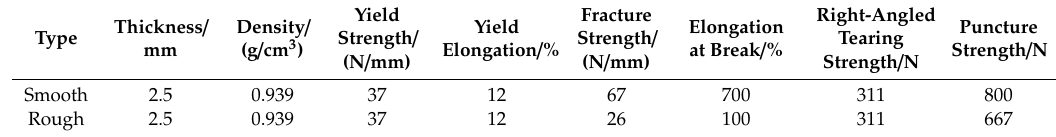
Table 1. Physical properties of HDPE geomembranes (minimum).